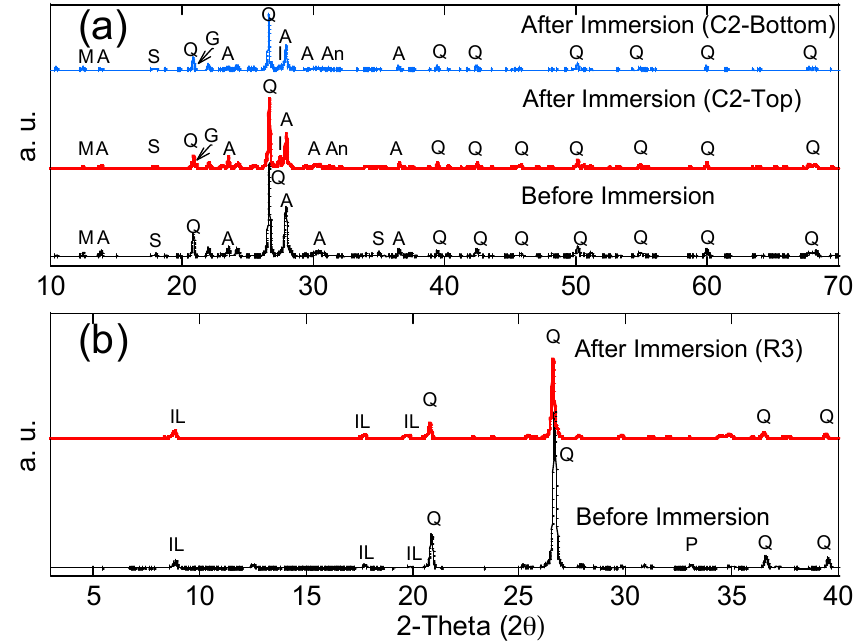
Figure 7. X-ray diffraction patterns of representative ( a ) concrete and ( b ) black shale specimens before and after immersion tests. Albite (A), Anhydrite (An), goethite (G), iron sulfate hydroxide (I), illite (IL), magnesium silicate hydroxide (M), pyrite (P), quartz (Q), and slaked lime (S).